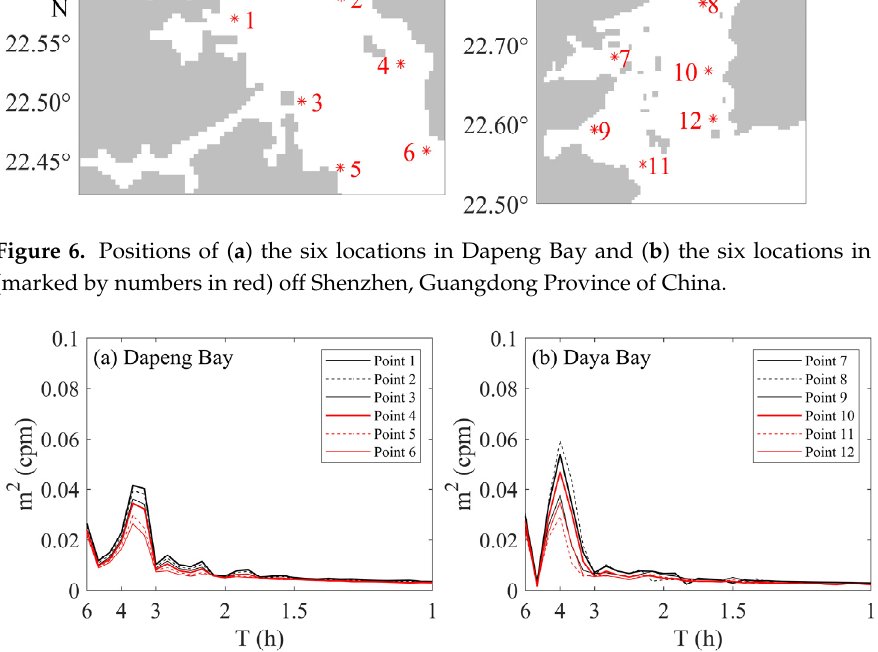
Figure 7. Power spectra of simulated sea levels at ( a ) the six locations in Dapeng Bay and ( b ) the six locations in Daya Bay based on results produced by the inner sub-model in the two-day period between 02:00 UTC on 17 September and 02:00 UTC on 19 September after Typhoon Mangkhut.